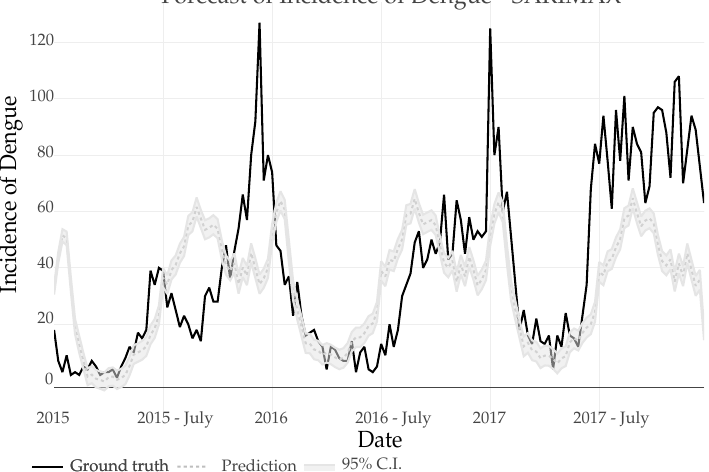
Figure 13. Prediction of Dengue Incidence for 3 years using a SARIMAX model and comparison with the real number of cases.